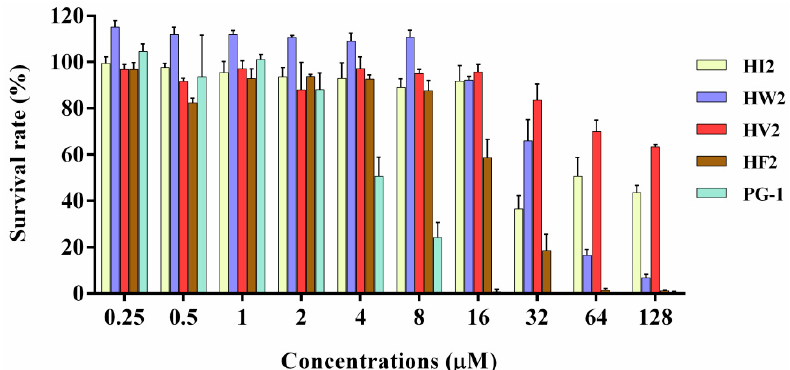
Figure 4. Cytotoxicity of peptides against RAW264.7. The peptides were incubated with RAW264.7 in a 96-well microtiter plate, and after incubation with MTT, the supernatant was discarded and dimethyl sulfoxide was added and the optical density (OD) at 570 nm was measured.